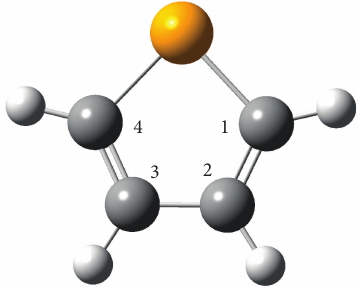
Table 1: Structural parameters of C